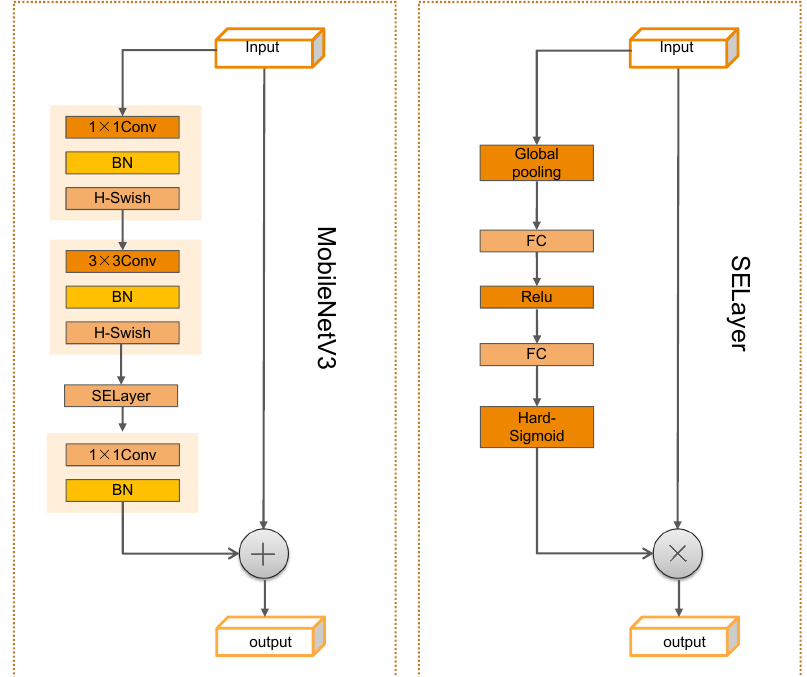
Figure 5. Basic composition of MobilenetV3 and the SE module.